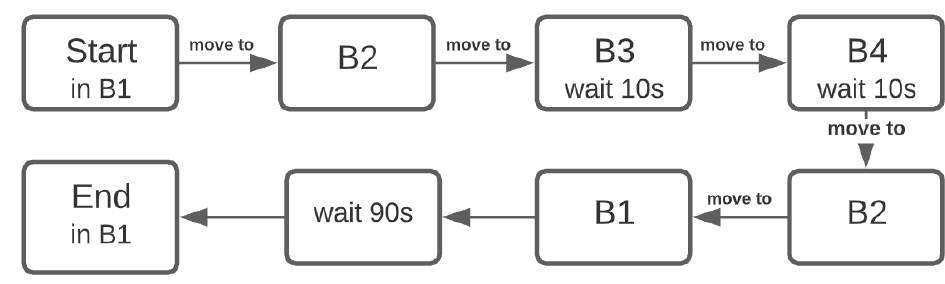
Figure 2. Mission algorithm used in the calibration experiment.